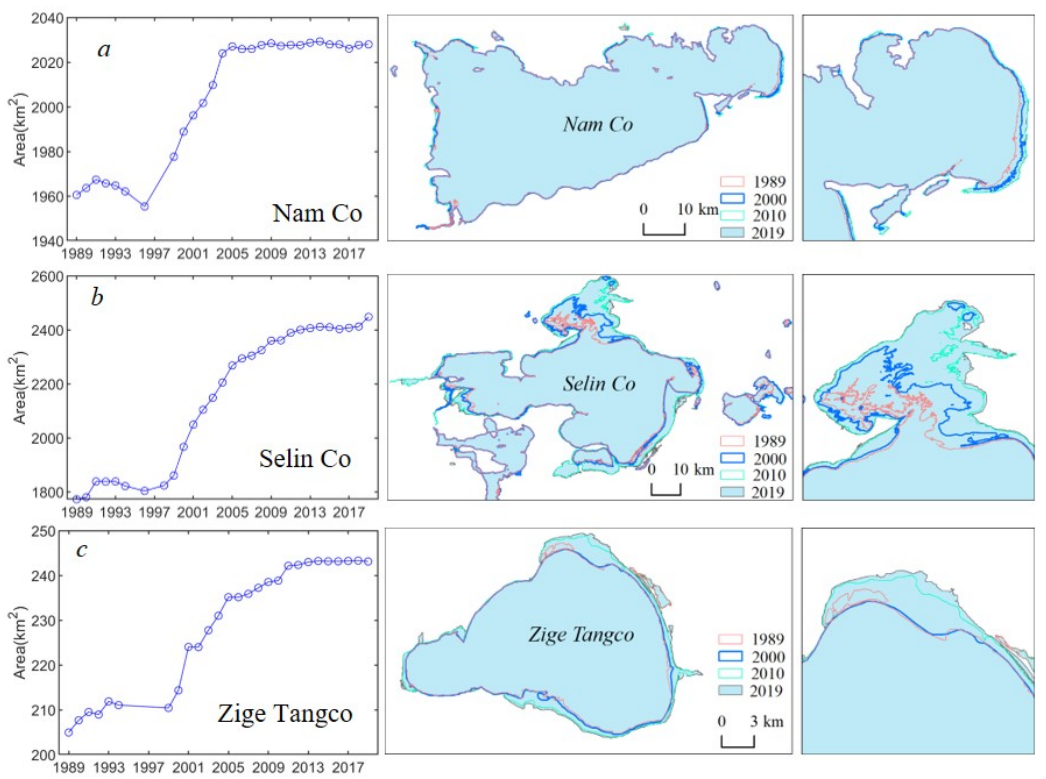
Figure 4. The obvious expansions of three representative lakes Nam Co ( a ), Selin Co ( b ), and Zige Tangco ( c ) in 1989–2019. The right two columns indicate lake boundaries of the three lakes in four years 1989, 2000, 2010, and 2019.